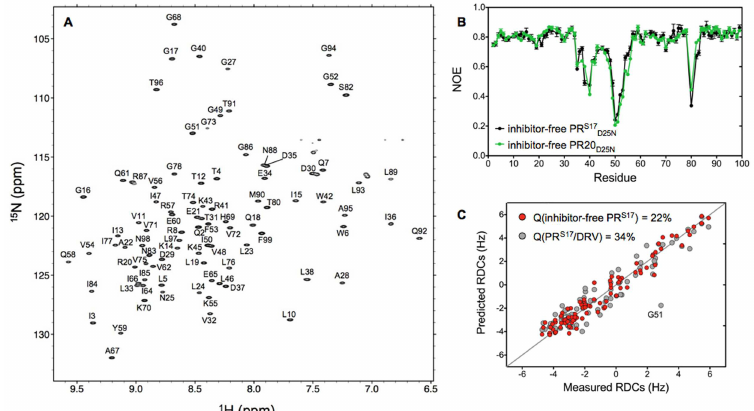
Fig 6. NMR Analysis of Solution Conformation of Inhibitor-free PR S17 D25N . A. 1 H- 15 N TROSY-HSQC spectrum of the inhibitor-free PR S17 D25N recordedin 20 mM sodium phosphate pH 5.7 at 20˚C. B. 15 N NOE measuredunder the same conditions for the inhibitor-free PR S17 D25N (black) and PR20 D25N (green) as a function of the residuenumber. C. Comparisonbetweenthe 1 D NH RDCs measuredfor the inhibitor-free PR S17 D25N in a dilute solution of squalamine with those predictedfrom the crystal structures of the inhibitor- free PR S17 (red dots) and PR S17 /DRV (gray dots). All the NMR experiments were recorded at 600 MHz.